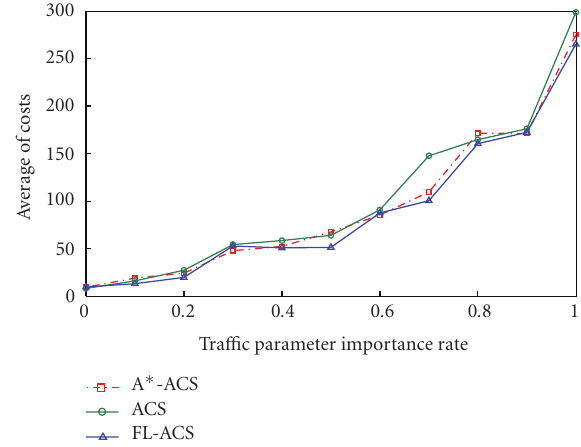
Figure 13: Average of 10 randomly selected O/D pairs cost averages for di ff erent number of cycles. A comparison between performance of ACS, A ∗ -ACS, and FLACS algorithms is presented for user preference: Distance = High; Tra ffi c = Low; Incident Risk = Low.